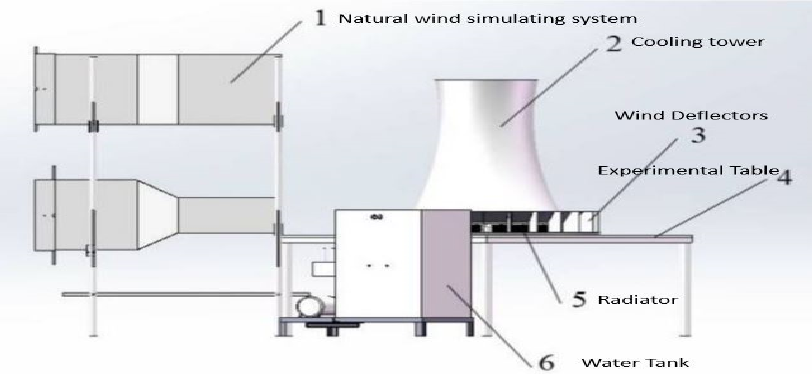
Figure 12. An experimental setup to investigate the effect of deflector in cooling tower [84].